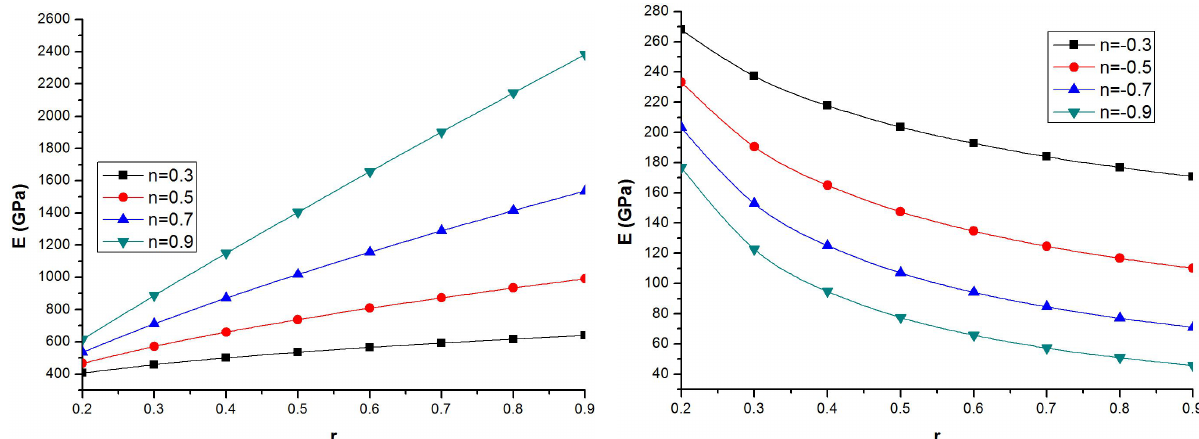
Figure 1: Represents variation in modulus of elasticity versus radial coordinate corresponding to positive and negative values of inhomo- geneity parameter